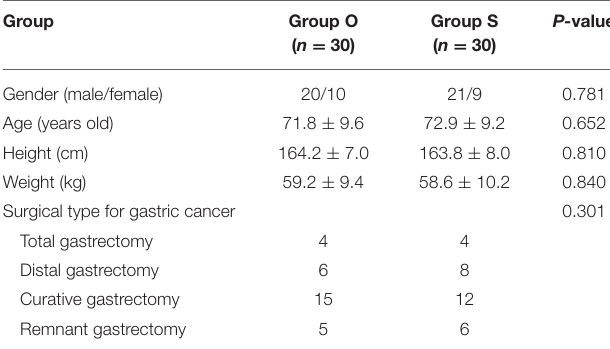
TABLE 1 | Comparison of general conditions between the two